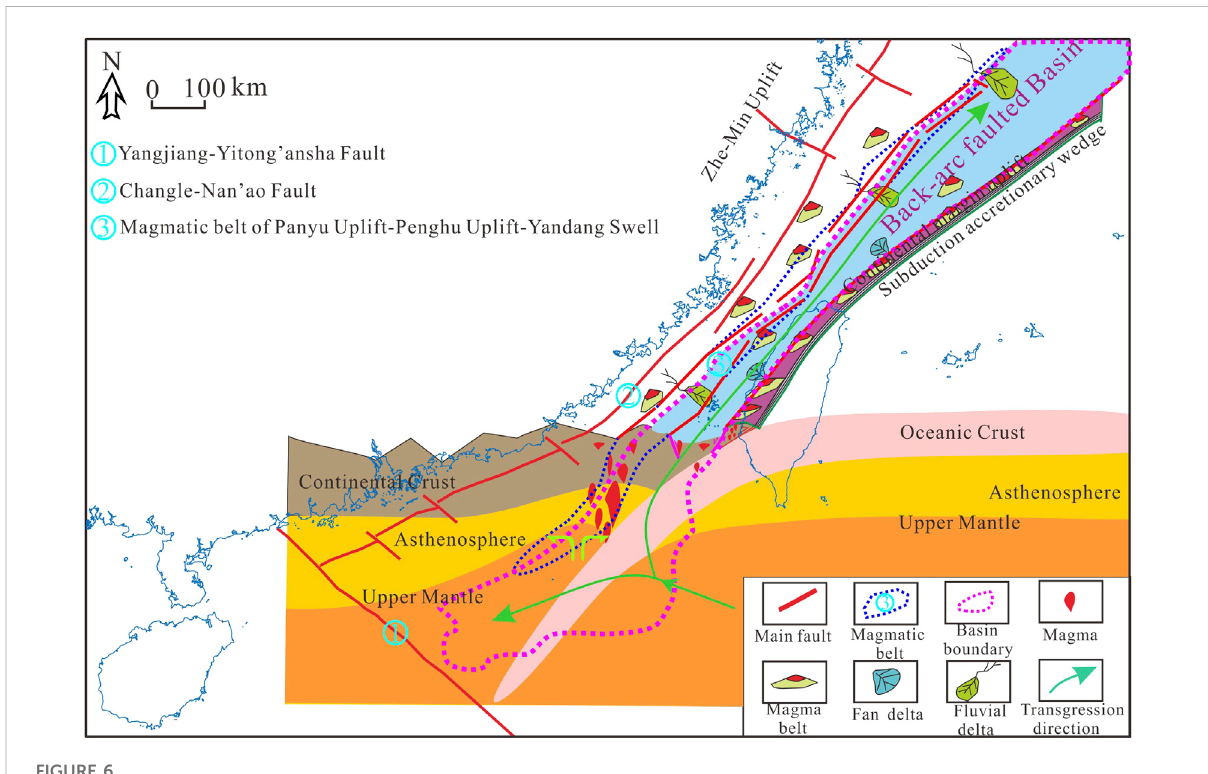
Plane view of the Late Jurassic – Early Cretaceous Basin (pink dotted line) and transgression direction (green arrow lines) in the NSCS-SECS, as wellasthesedimentarysystemintheSECS.Intheverticalsection,weshowthedeepstructuralfeatures,themagmaactivity,andthebasinformation mechanism (modi fi ed from Zhou et al., 2005; Yi et al., 2012; Wu, 2014; Wang et al., 2022a;